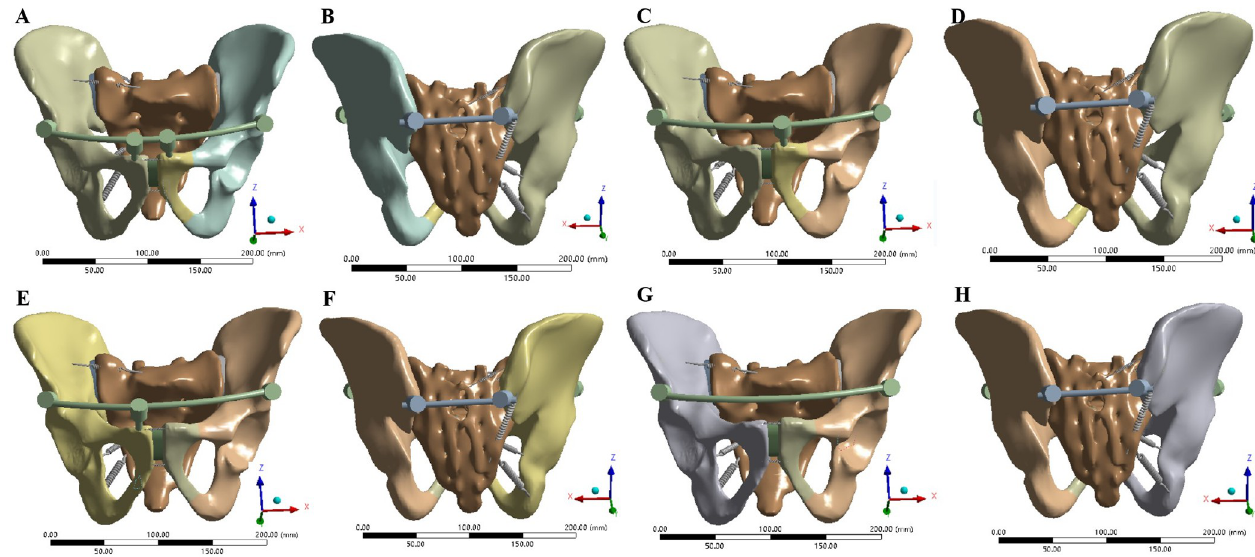
Fig 3. FE model Tile C1 pelvic fractures fixed with pedicle screws and rods. (A-B) Two screws in the pubic area. (C-D) One screw in the pubic area on the injured side. (E-F) One screw in the pubic area on the uninjured side. (G-H) No screws were placed in the pubic area on either side. https://doi.org/10.1371/journal.pone.0273351.g003 follows: 2 screws were added to the pubic region (method 1), 1 screw was added to the injury side of the pubic region (method 2), 1 screw was added to the healthy side of the pubic region (method 3), and no screw was added to the pubic region (method 4). The four pedicle screw placement methods are shown in Fig 3. Screws with diameters of 6.5 mm (D1), 7.0 mm (D2) and 8.0 mm (D3) were used for each screw placement method. The steel plate fixation model and the pedicle screw fixation model were automatically meshed using Ansys Workbench 16.0 software. The mesh size of the pelvis model was set to 10 mm, the mesh size of the steel plate was 1 mm, and the mesh size of the rod screw was 5 mm. After meshing, the steel plate fixed model had 446217 elements and 255952 nodes. The FE model of pedicle screw-rod fixation was grouped according to the method of screw placement in the pubic region and the diameter of the pedicle screw. The number of elements and nodes of the pedicle screw-rod fixation model are shown in Table 3. Table 3. FE Model grouping and number of elements and nodes for pedicle screw fixation.